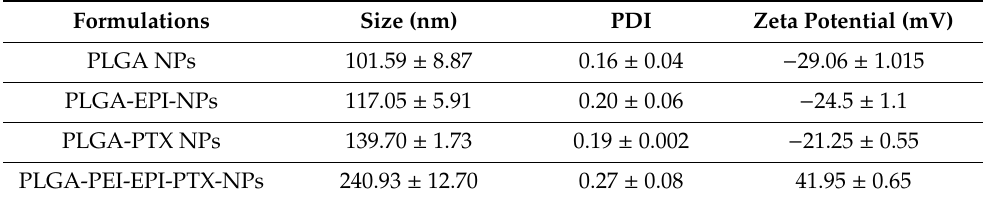
Figure 2. Illustrative DLS spectrum and AFM images of ( A ) DLS spectrum of void PLGA NPs here size is 95.5 nm, ( B ) AFM image of void PLGA NPs here average size is 70 nm, ( C ) DLS spectrum of PLGA ‐ PEI ‐ EPI ‐ PTX NPs here size is 241.3 nm, ( D ) AFM image of PLGA ‐ PEI ‐ EPI ‐ PTX NPs here average size is 140 nm. Table 1. Represents the nanoparticles size, polydispersity index and zeta potential. Data are shown as mean ± SD (n = 3).